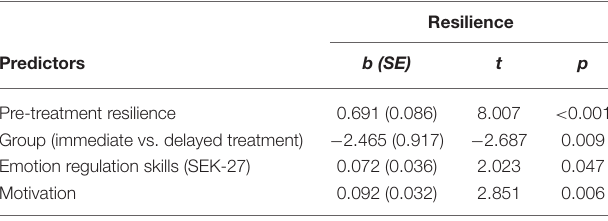
TABLE 4 | Predictors of the post-treatment resilience (multiple